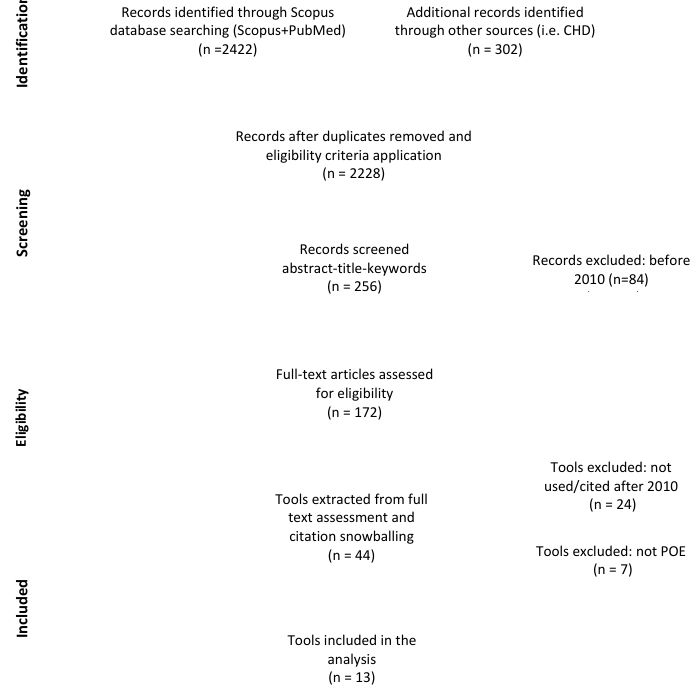
Table 1. Keyword identification and eligibility criteria used.